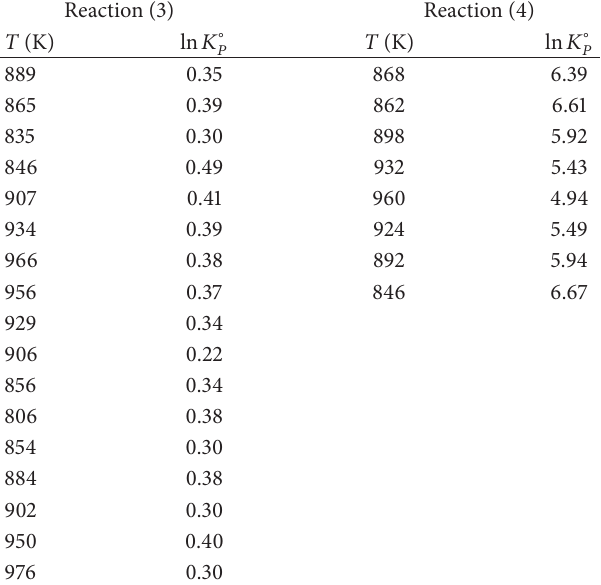
Table 5: Experimental data for reactions (3) and (4). Reaction